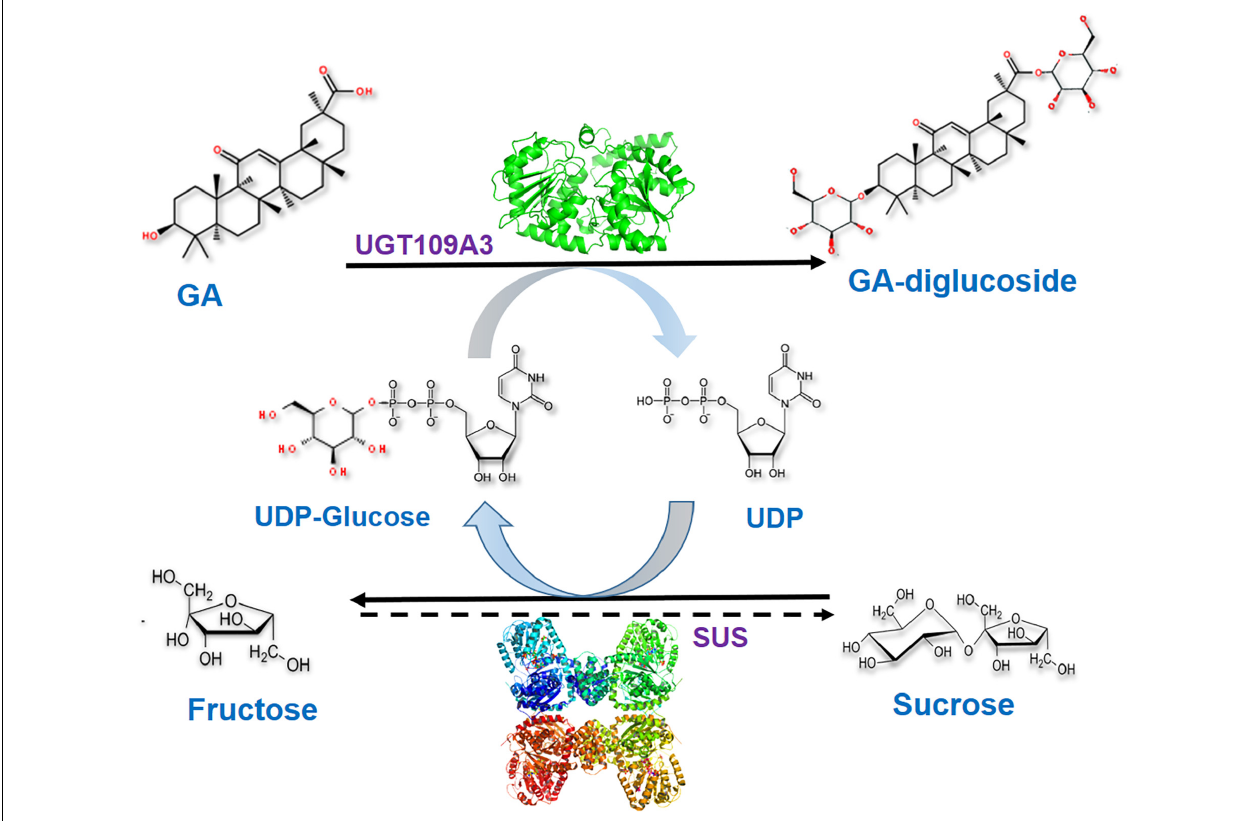
FIGURE 4 | The biocatalytic cascade reaction catalyzed by UGT109A3 and SUS. The artificial cascade of UGT109A3-SUS potentially facilitates the conversion of GA into a 3, 30- O - β - D -diglucoside-GA, along with the costly UDPG sugar donor regeneration.